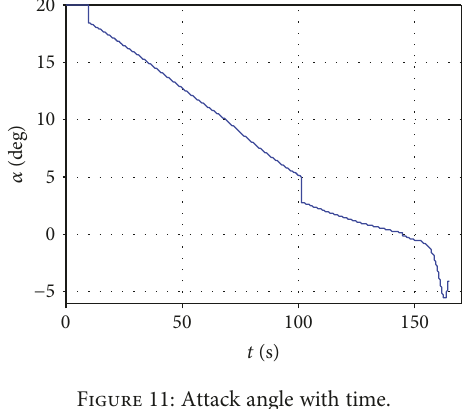
Figure 11: Attack angle with time.